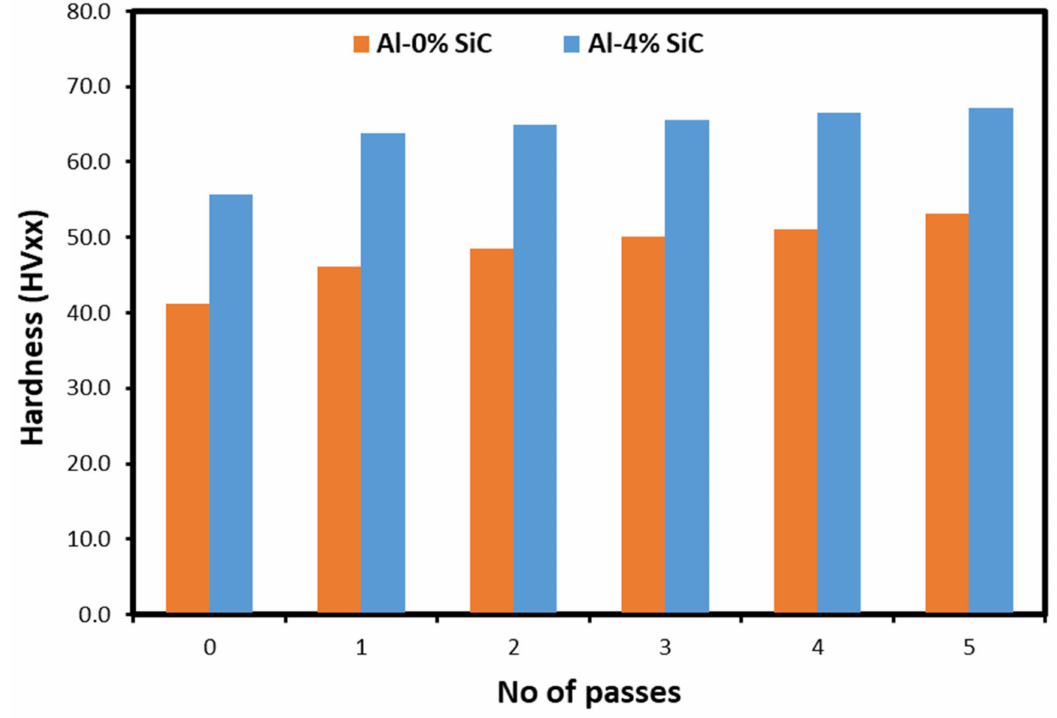
Figure 8. Microhardness of Al–SiC nanocomposite sheets after five ARB passes. In the figure, xx is the load in